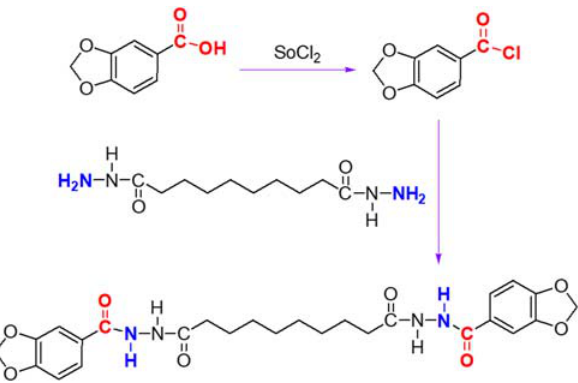
Figure 1: Synthetic route of